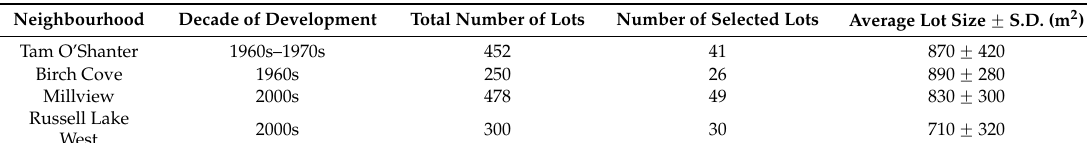
Table 1. Neighbourhoods examined in Halifax.